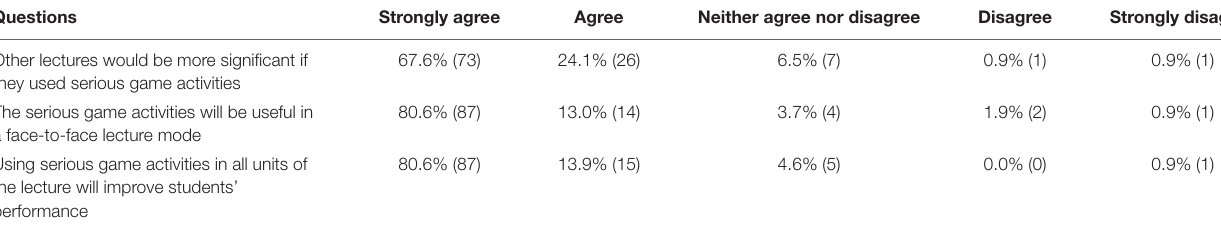
TABLE 4 | Percentage of responses to questions on the perception of students about the future impact of the model. Questions Strongly agree